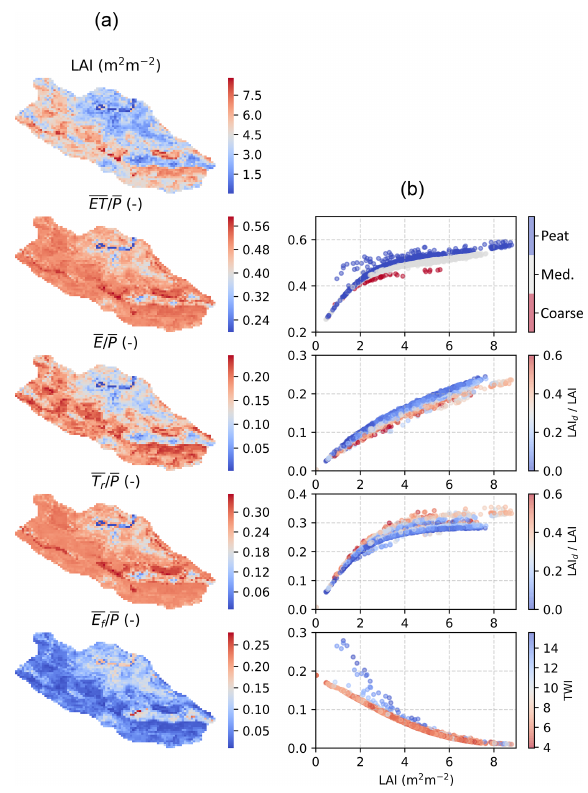
Figure 10. Spatial variability of evaporation fraction ET /P and its components at C3 catchment in Eastern Finland from a long-term (2006–2016) run (a) . The relationship of component fluxes inter- ception evaporation E , transpiration T r and forest floor evaporation E f on LAI (b) is modified with spatial variability of soil type, pro- portion of deciduous trees (LAI d / LAI) and topographical wetness index (TWI).